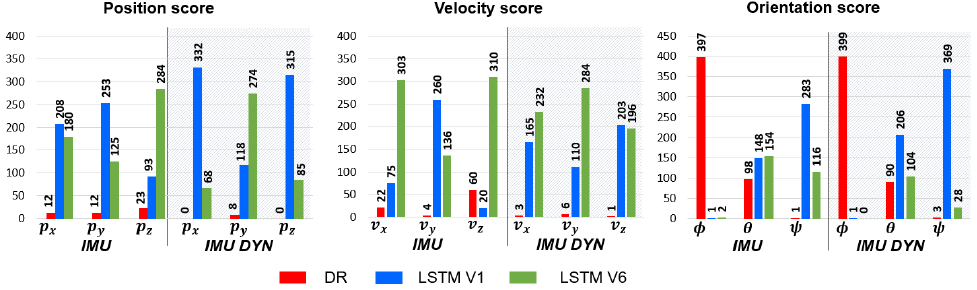
Figure 12. Position, velocity and orientation score obtained by LSTM IMU , V LSTM IMU DYN , V